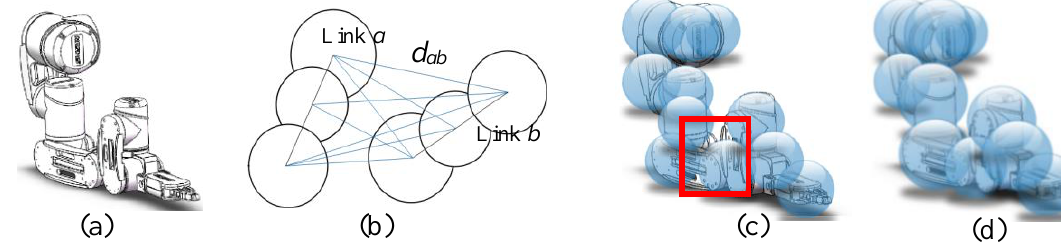
Figure 3. Collision model of the right arm, showing the distance between sphere bounding volumes. ( a ) the robot arm; ( b )the distance between different spheres with different radii; ( c ) building a collision model using discretized finite spherical volumes with same radii at specific positions ; ( d ) building a collision model using discretized finite spherical volumes with different radii at specific positions. The minimum distance between these bounding volumes produces the repulsive velocity.